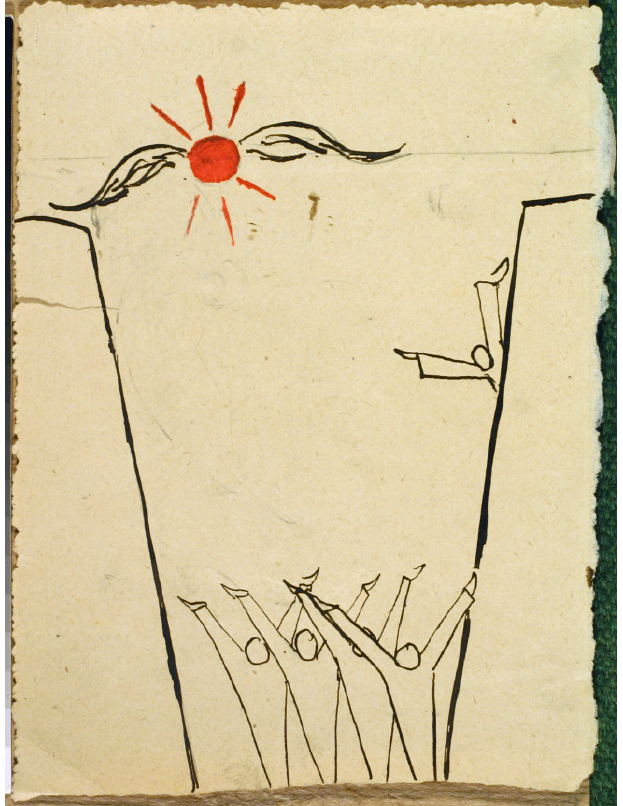
Figure 10. Andrei Bely. Drawing (sketch for the journal cover Dreamers’ Notes ?). 1918–1919.